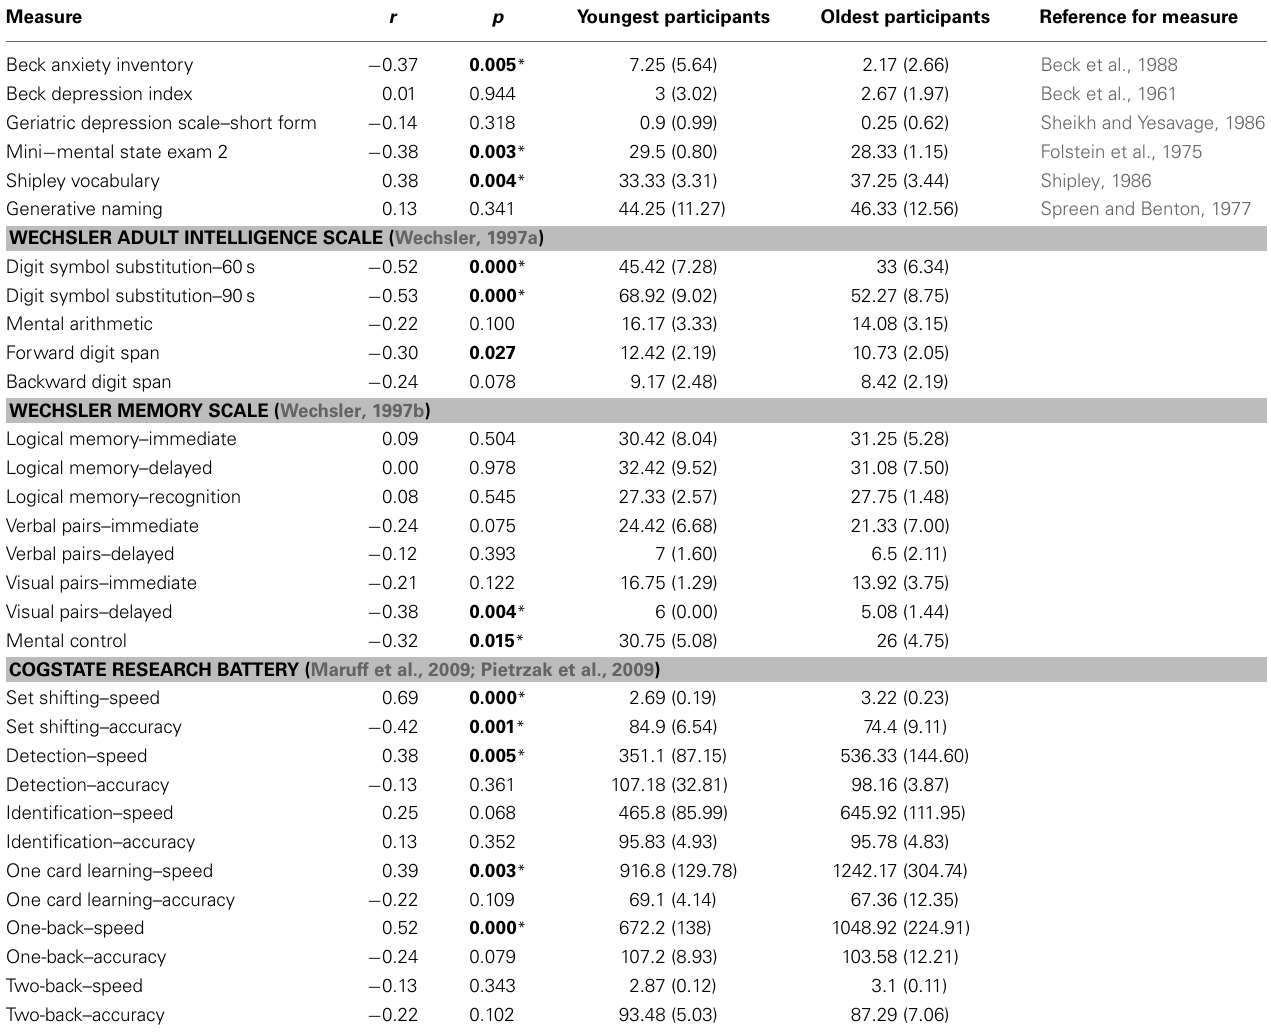
Table 1 | Correlations between age and cognitive tests from all 55 subjects, with averages and standard deviations from 12 youngest and 12 oldest